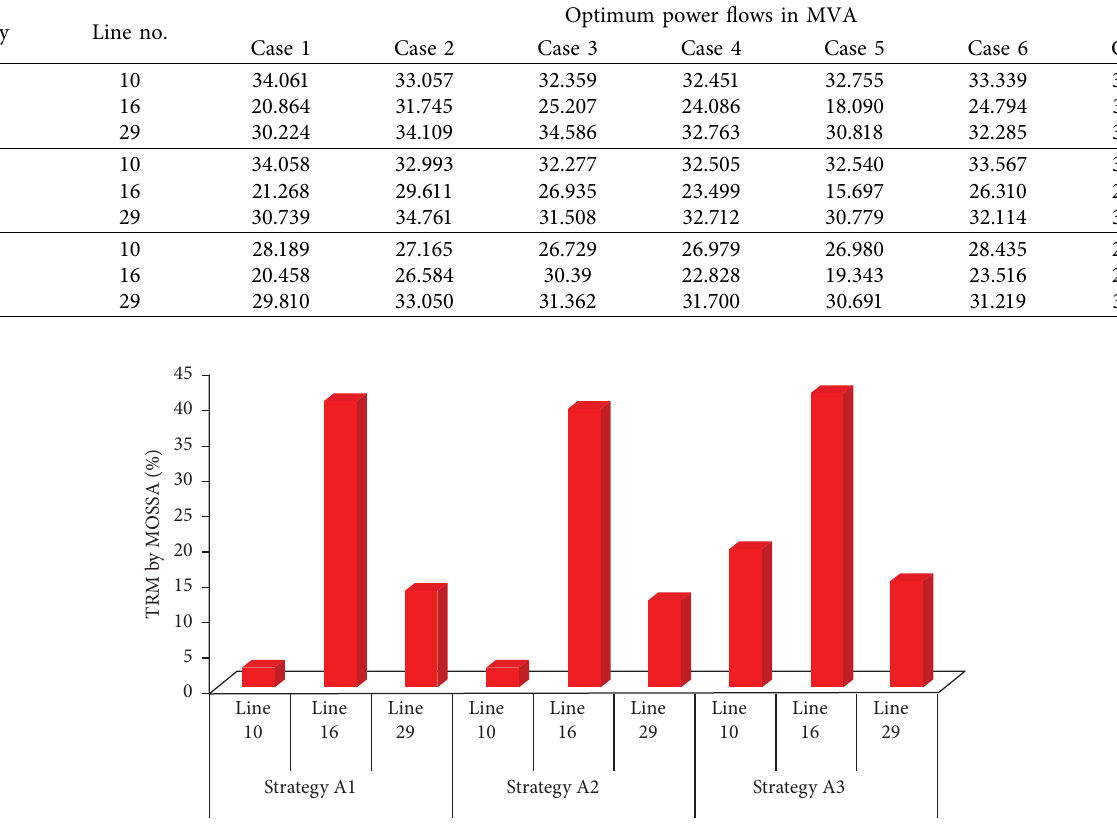
Table 8: Optimized power fow for all strategies of group A.